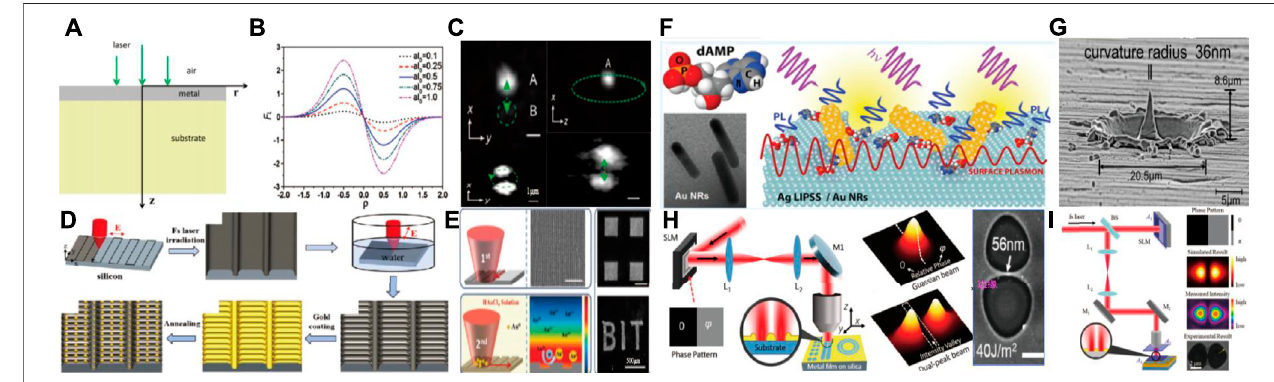
FIGURE 1 | Femtosecond laser top-down preparation method fi gure (A) Schematic view of the fabrication of the MTMO grayscale photomasks [39] (B) femtosecond laser capture of Au nanoparticles [40] (C) experimental results of gold nanoparticles trapped by femtosecond laser [40] (D) AuNPDN substrate manufacturing process diagram [42] (E) Schematic diagram of Au 3+ reduction in two steps [43] (F) schematic diagram of laser induced gold nanorod plasma nanostructure [44] (G) side view of a nanopin made by optical vortex [45] (H) space shaping experimental setup and pulse ablation of metal fi lms [46] (I) spatial shaping experimental setup and step-by-step experimental procedures